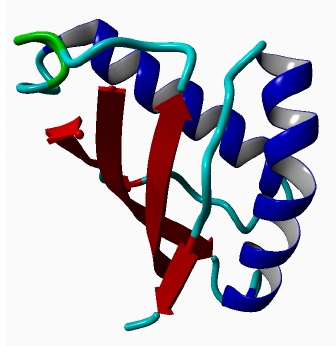
Figure 1. Ribbon structure of the macromolecule MUC1 drawn using YASARA. It is a complex of two protein chains. The first is built of 66 AA and the second of 55 AA. The structure was taken from